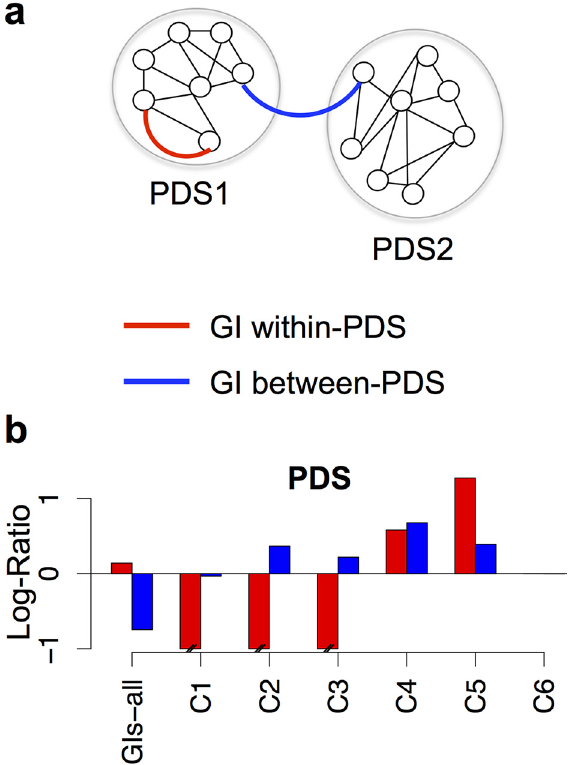
Fig 4. GI classes define PDS-depend and -independent modules. (a) Schematic representation of possible relationships between genetic interactions (GIs) and protein-protein dense subnetworks (PDS). Each node represents a gene being part of PDS1 or PDS2. A red line indicates a within-PDS GI and a blue line, a between-PDS GI. (b) Log-Ratio scores for within-PDS (red bars) and between-PDS (blue bars) relationships observed between genes interacting through different GI classes, or present in GIs-all. A positive Log-Ratio score means that the frequency of within- or between-PDS GIs occurring in the GI class is significantly higher than the frequency of similar situations witnessed in relevant randomized GI networks with a probability of 0.99 (see Methods).